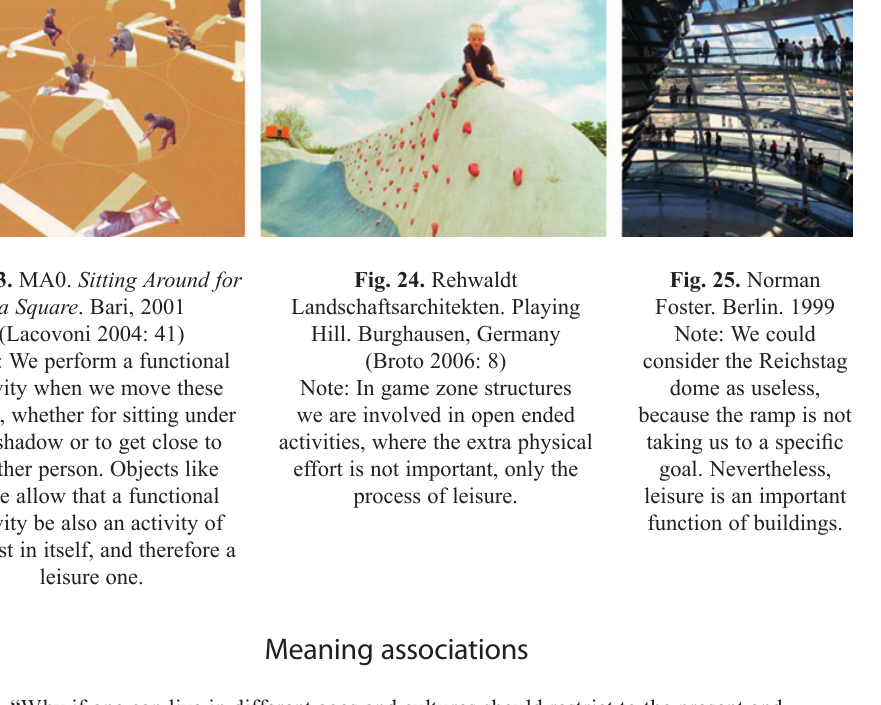
Fig. 23. MA0. Sitting Around for Fig. 24. Rehwaldt